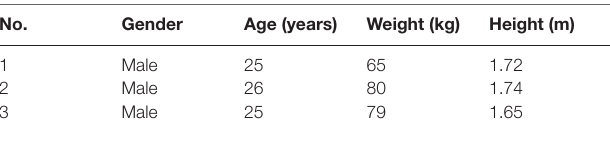
taBle 1 | Characteristics of the study